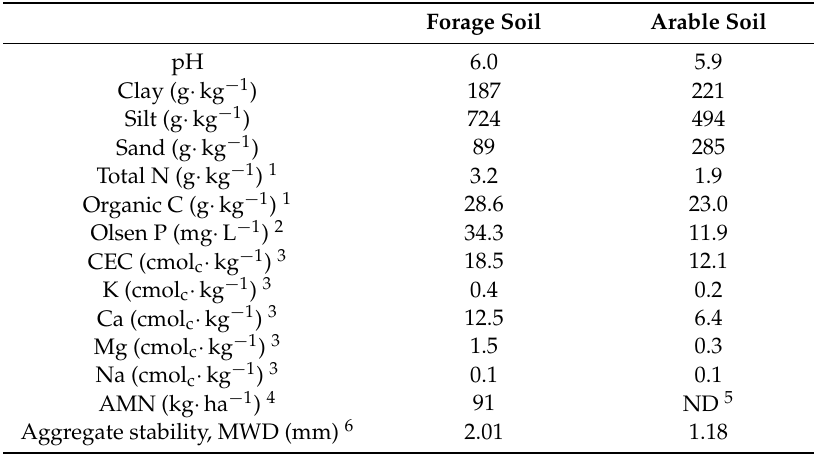
Table 2. Baseline soil chemical and physical measurements (0–15 cm) prior to establishing the Forage (2007) and Arable trials